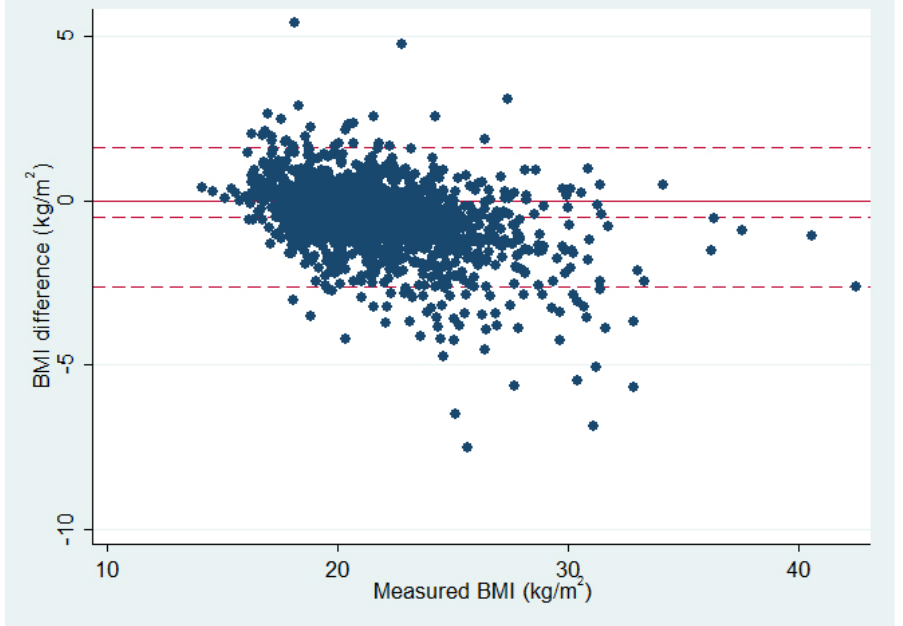
Figure 3. Bland-Altman plot of difference between self-reported and measured BMI (y-axis) in relation to measured BMI (x-axis). The solid line shows difference equal to zero and the dashed lines show mean difference ±2